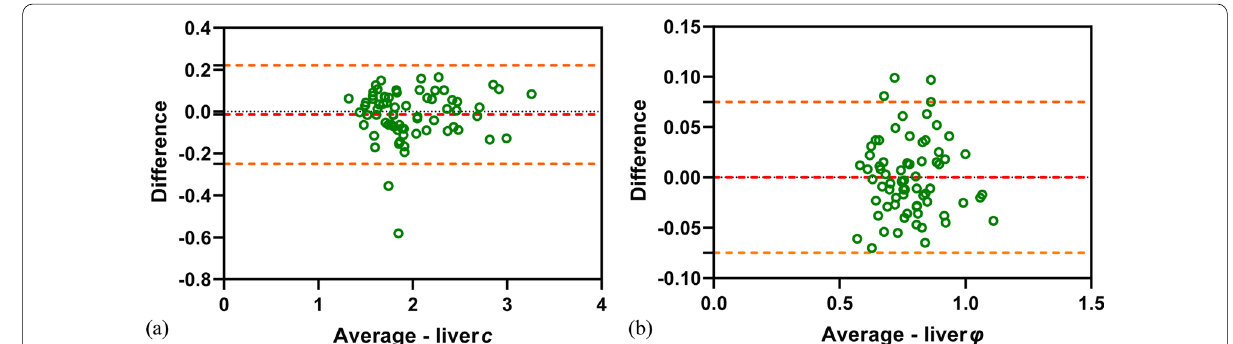
Fig. 2 Bland–Altman plots showing agreement between liver c and φ values evaluated by two independent